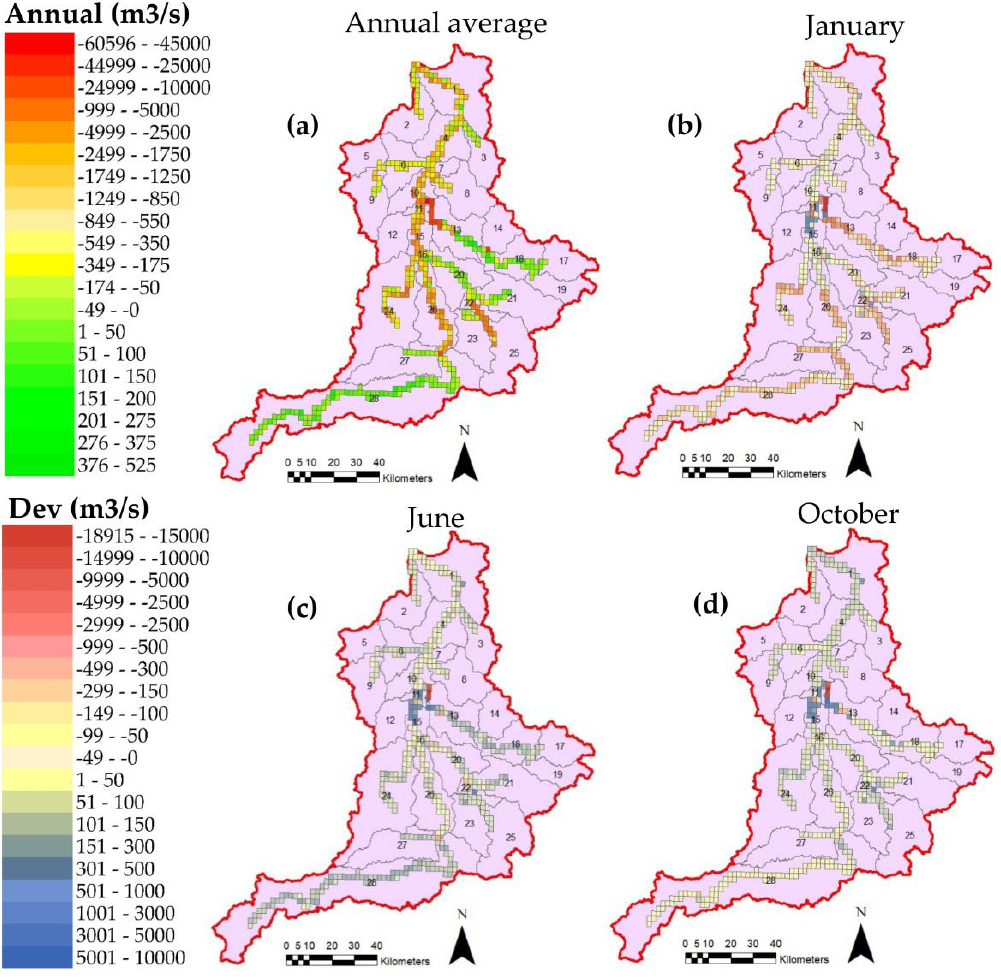
Figure 8. Long-term (1986–2007) average monthly groundwater–surface water (GW–SW) exchange differences from the average annual ( a ) for each MODFLOW river cell, in the months of January ( b ), June ( c ), and October ( d ). Dev (m 3 /d) = monthly (m 3 /d) − yearly (m 3 /d).